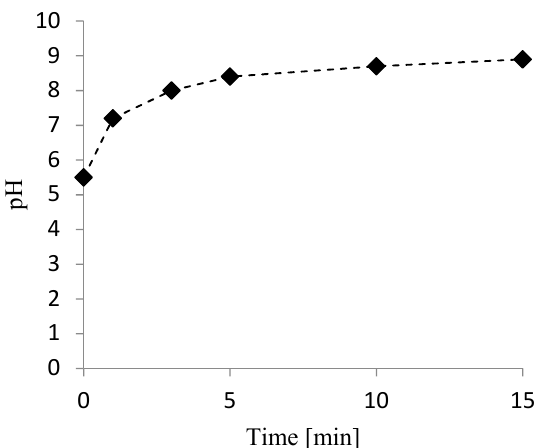
Figure 5. pH evolution during nitrate removal. Condition: unbuffered pH, T = 298 K, 0.2 g L − 1 bimetallic nanoparticles, and [NO 3 − ] = 300 mg L − 1 .